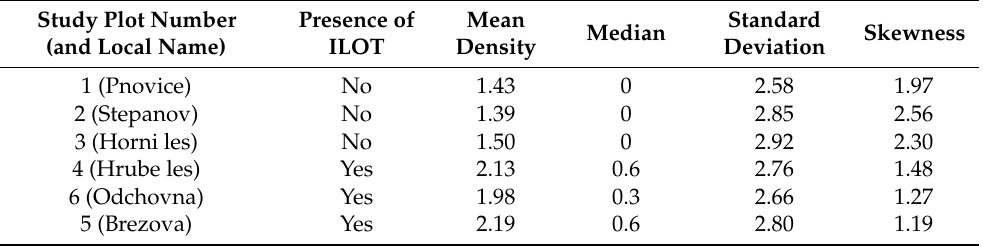
Table 2. Descriptive statistics for study plot Table 2. D escriptive statistics for study plot areas.